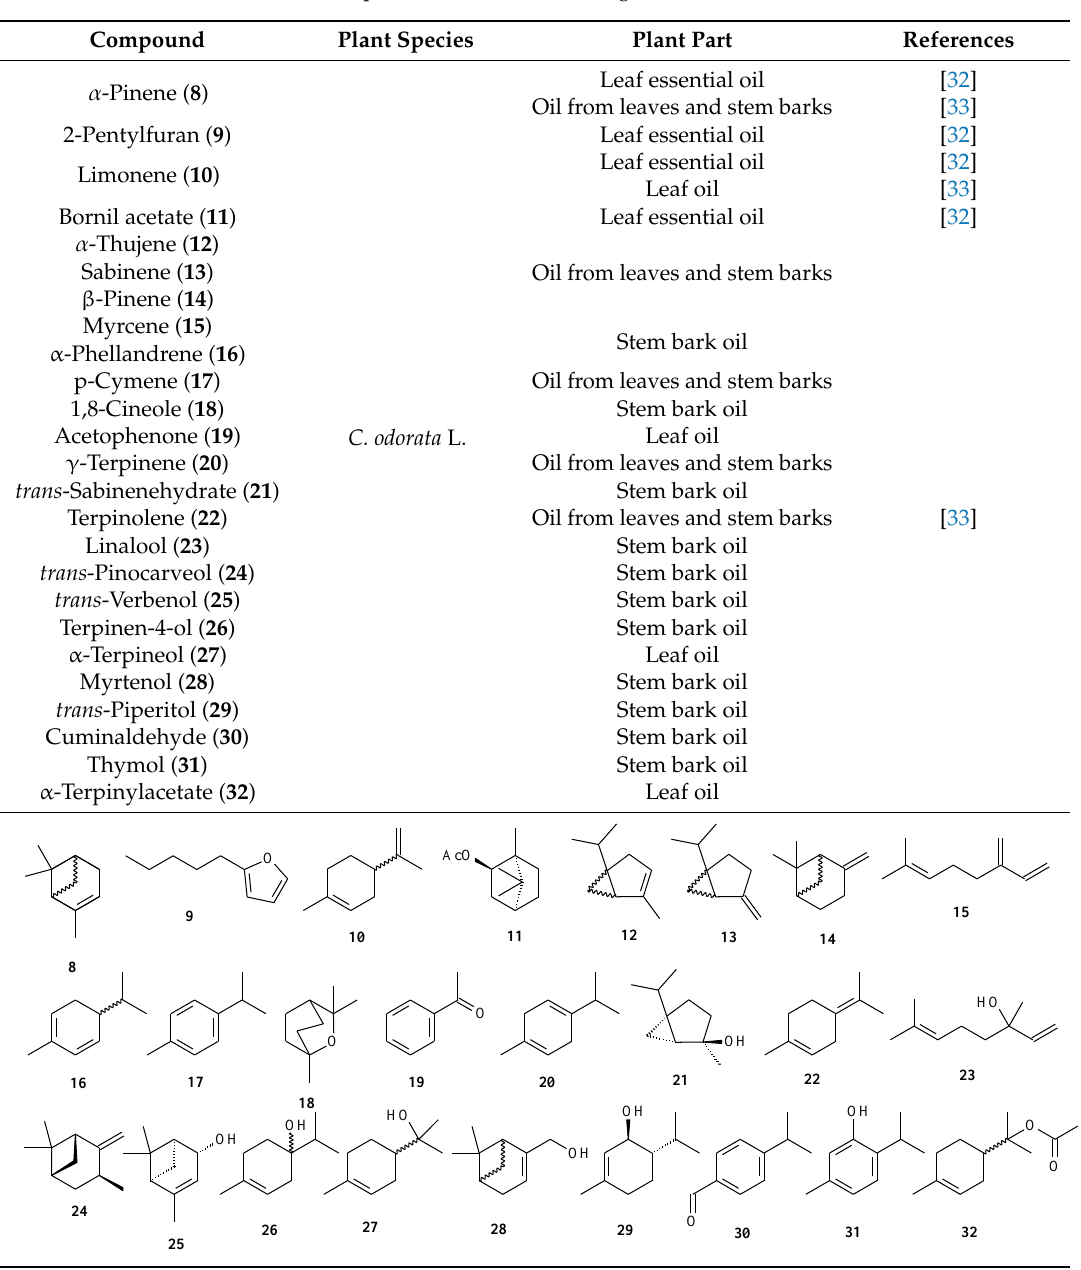
Table 5. Sesquiterpenes identified from the genus Cedrela